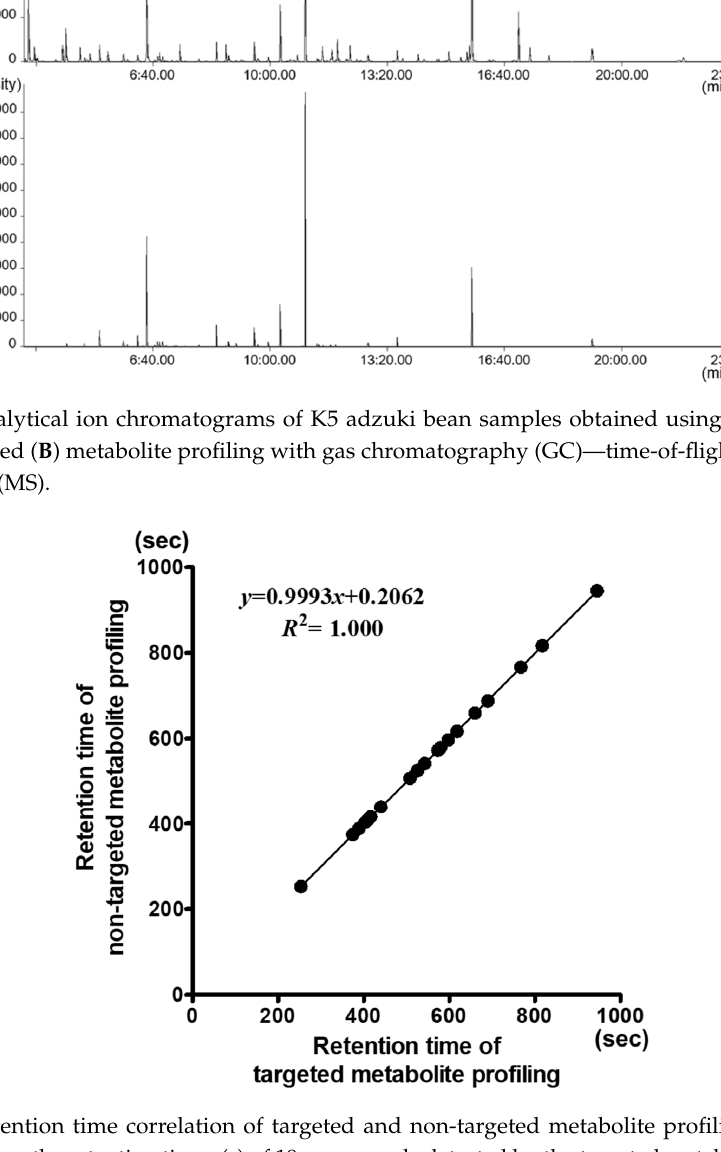
Figure 2. Retention time correlation of targeted and non-targeted metabolite profiling platforms. The